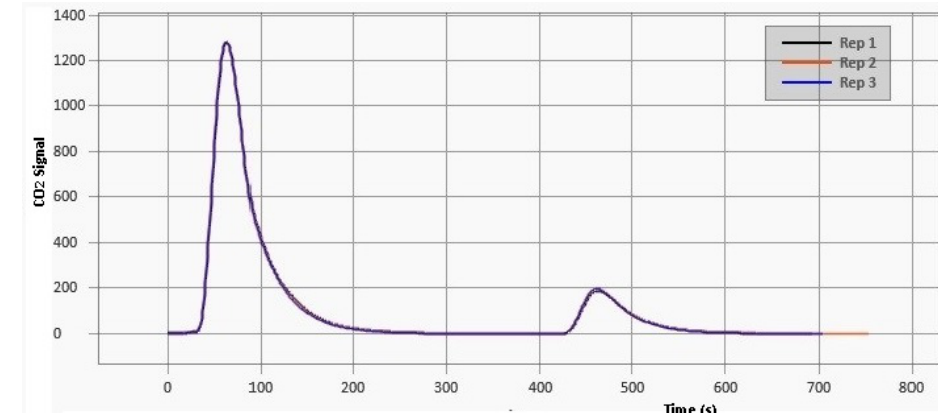
Figure 4 – TOC spectrum of surface water: the left high peak belongs to total inorganic carbon (TIC), the lower right one belongs to total organic carbon (TOC) Рис . 4 – Спектр TOC поверхностных вод : левый верхний пик относится к общему неорганическому углероду (TIC), нижний правый пик относится к общему органическому углероду (TOC) Слика 4 – Спектар ТОЦ површинске воде , леви виши пик припада укупном неорганском угљенику (T ИЦ ), а нижи десни пик укупном органском угљенику ( ТОЦ